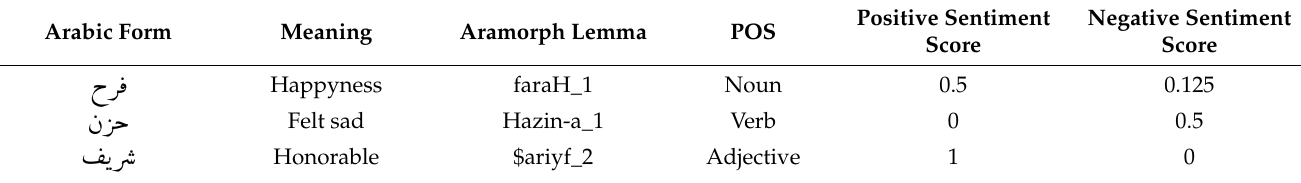
Table 3. Sample of ArSenL lexicon.